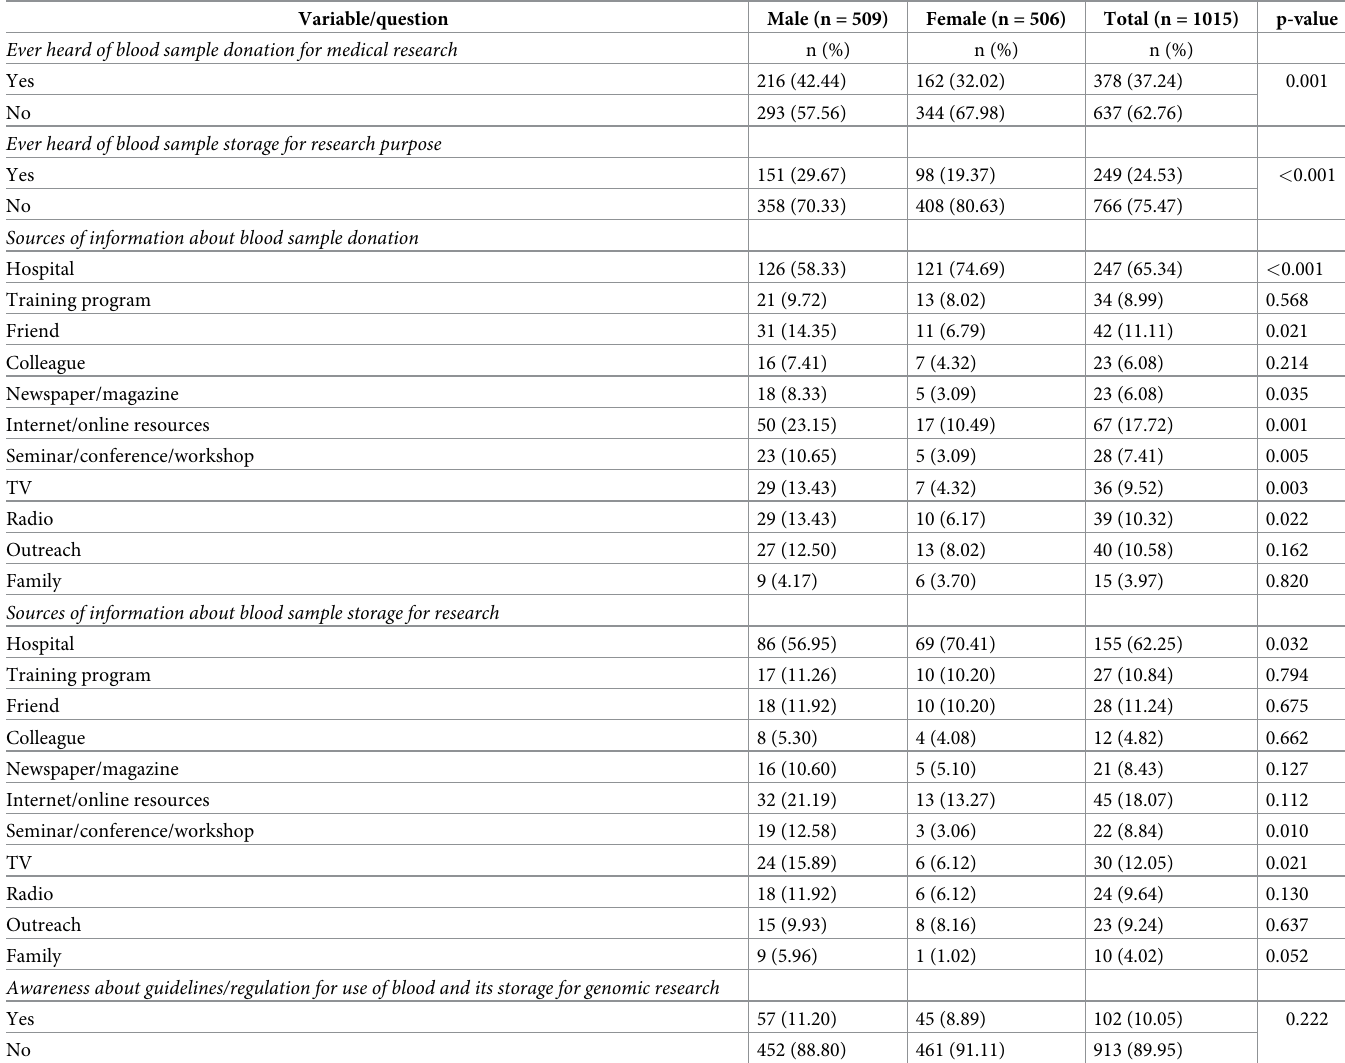
Table 2. Awareness and knowledge related to blood sample